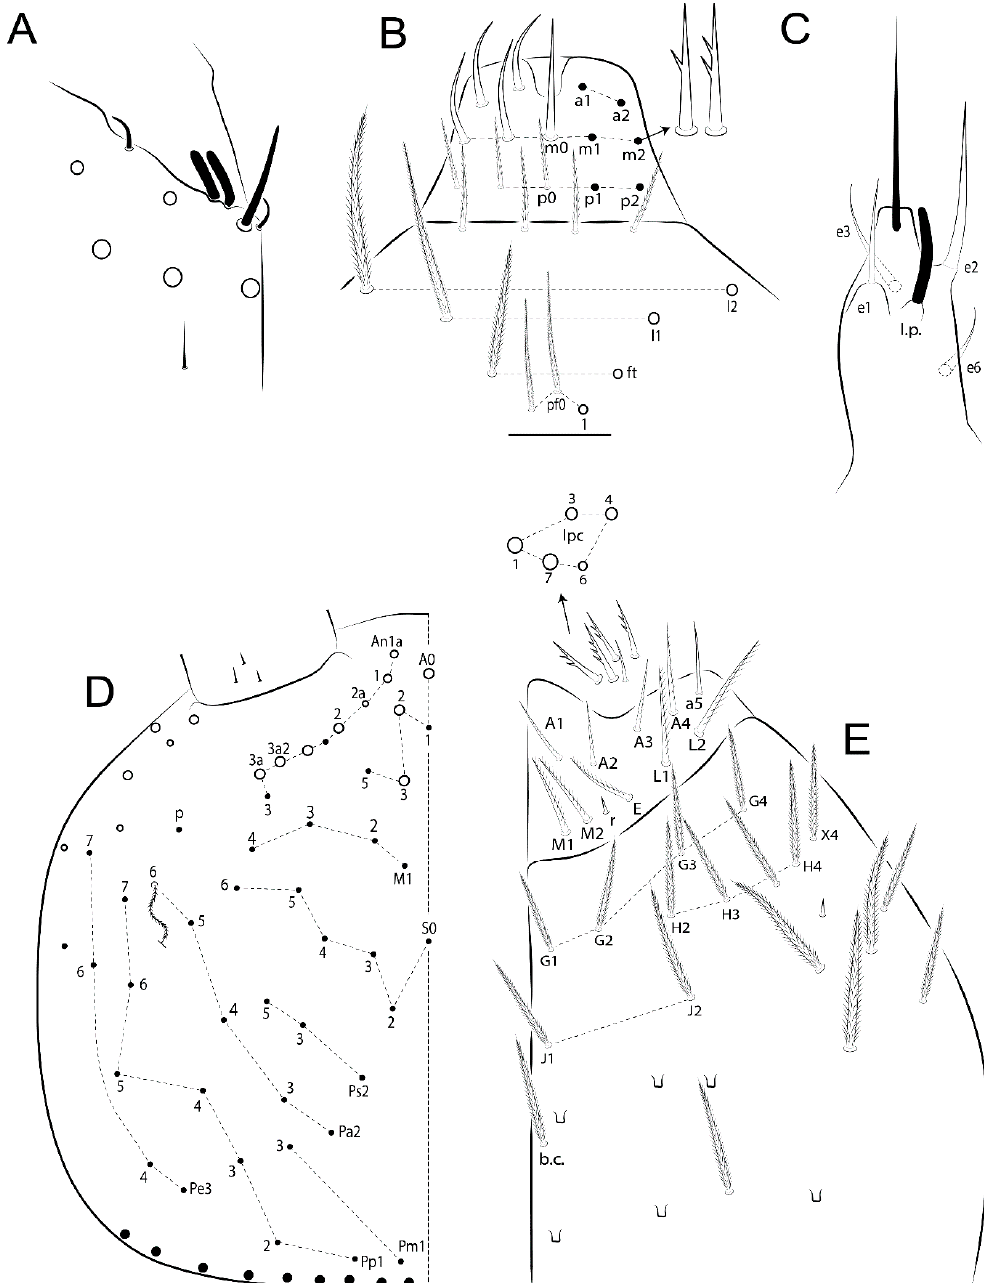
Figure 16. Pseudosinella keni sp. nov.: head. ( A ) Ant III apical organ (lateral view); ( B ) chaetotaxy of clypeus, prelabrum and labrum, arrow indicate m1–m2 chaetae with 1 or 2 median filaments; ( C ) labial papilla E (right side); ( D ) head dorsal chaetotaxy (left side); ( E ) labial proximal chaetae, basomedian and basolateral labial fields and complete postlabial chaetotaxy (right side), arrow indicate proximal chaetae nomenclature.